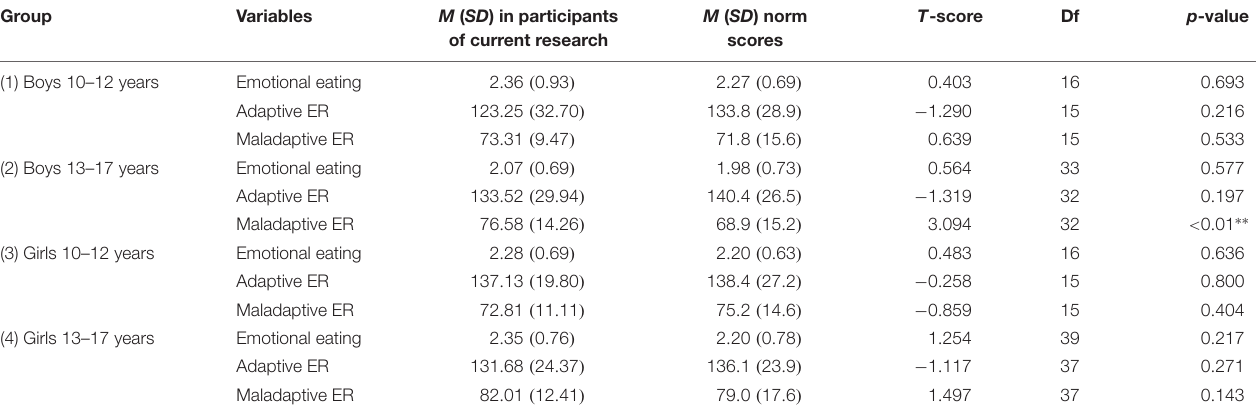
TABLE 1 | Comparison of means with gender- and age specific norm scores. Group